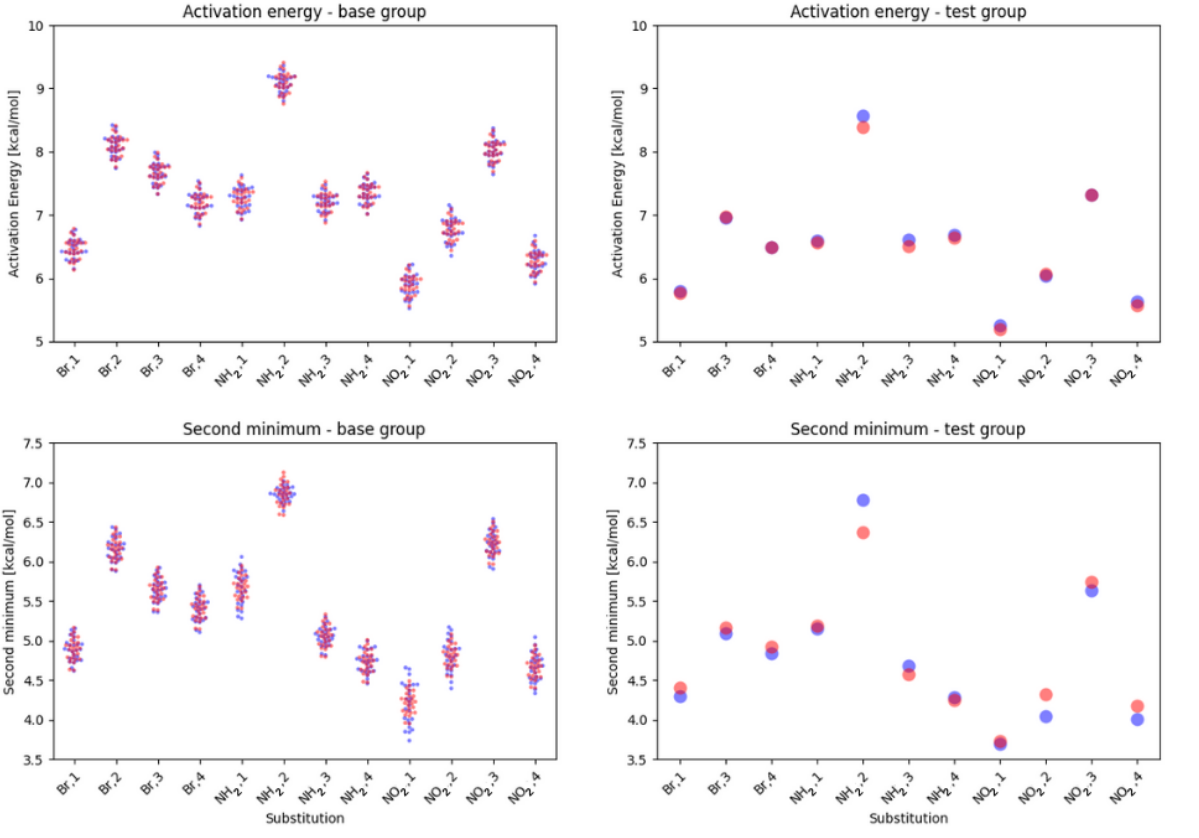
Figure 11. Model performance for base compounds ( left ) and test compounds ( right ). The experi- mental values are shown in blue, while the model-based values are shown in